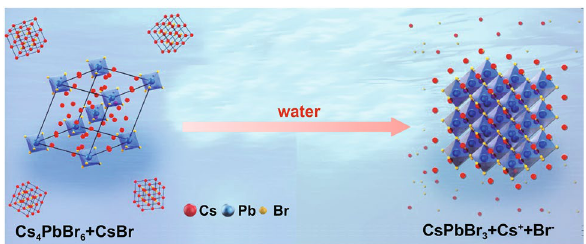
Fig. 1 Schematic of the phase transformation from CsBr/Cs 4 PbBr 6 to CsPbBr 3